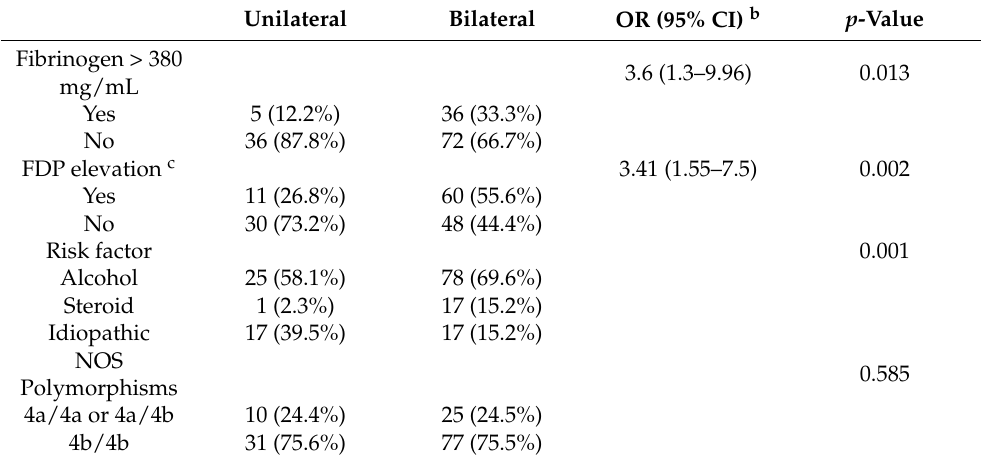
Table 3. Risks for Bilateral Hip Involvement in ONFH.